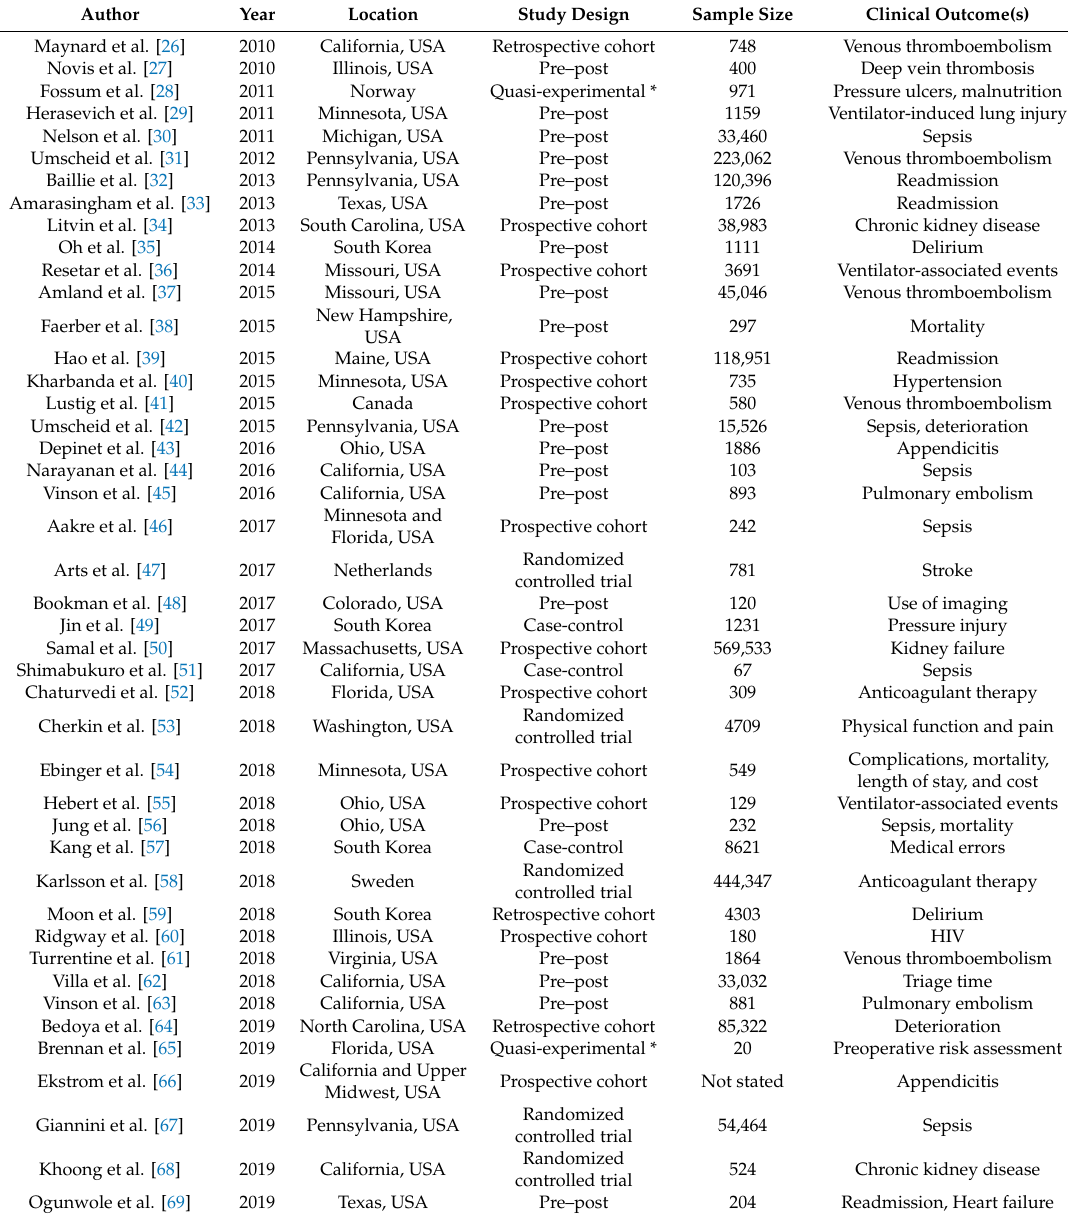
Table 1. Overview of included studies pertaining to predictive models embedded in electronic health record (EHR) systems implemented in clinical settings. * Quasi-experimental study design refers to other non-randomized clinical trials that did not qualify as pre–post